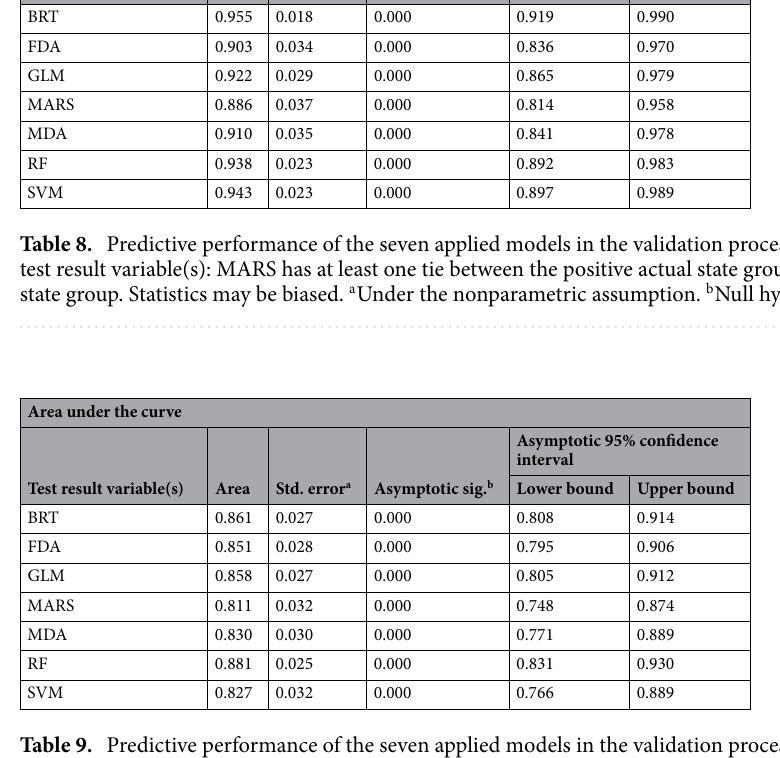
Table 9. Predictive performance of the seven applied models in the validation process of collapsed pipes 2021. a Under the nonparametric assumption. b Null hypothesis: true area = 0.5.